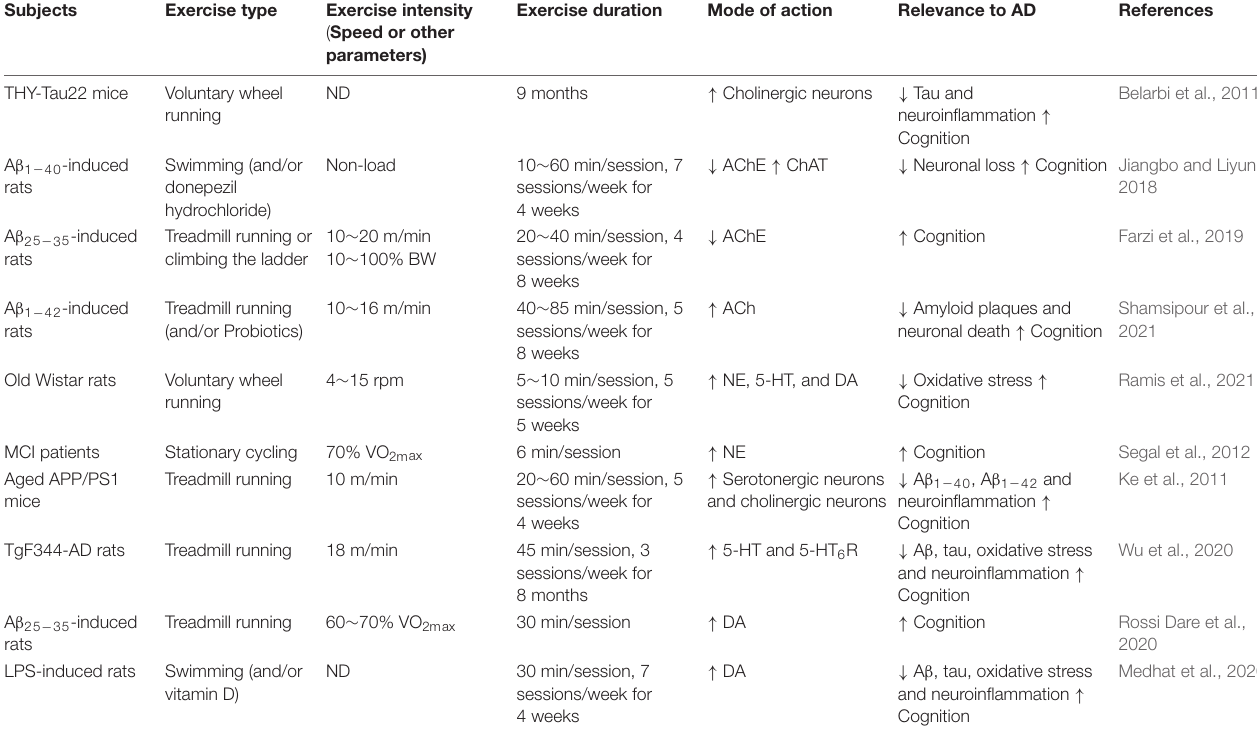
TABLE 5 | Exercise effects on the cholinergic and monoaminergic systems in Alzheimer’s disease.